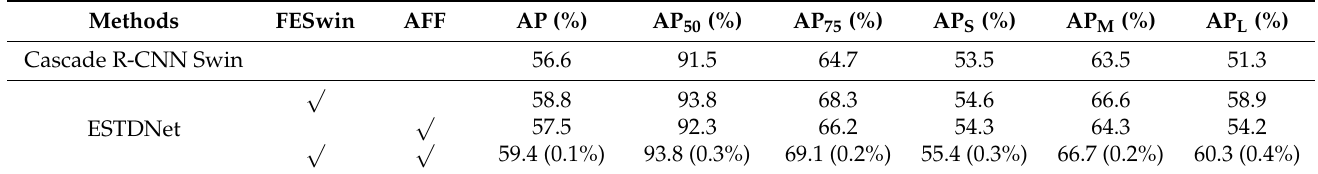
Table 6. The experimental result of ESTDNet on the SSDD